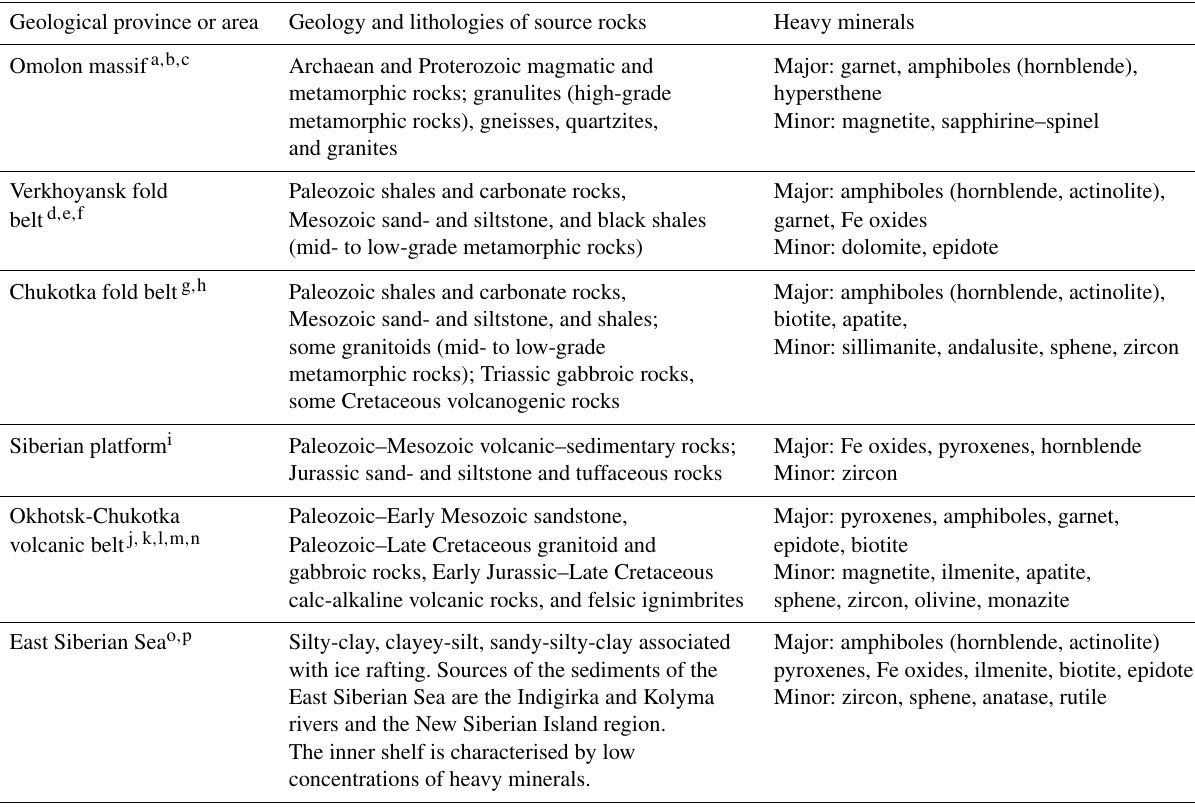
Table 1. Summary of lithological and mineralogical characteristics of the source areas and rocks for the De Long Trough and southern Lomonosov Ridge sediments.